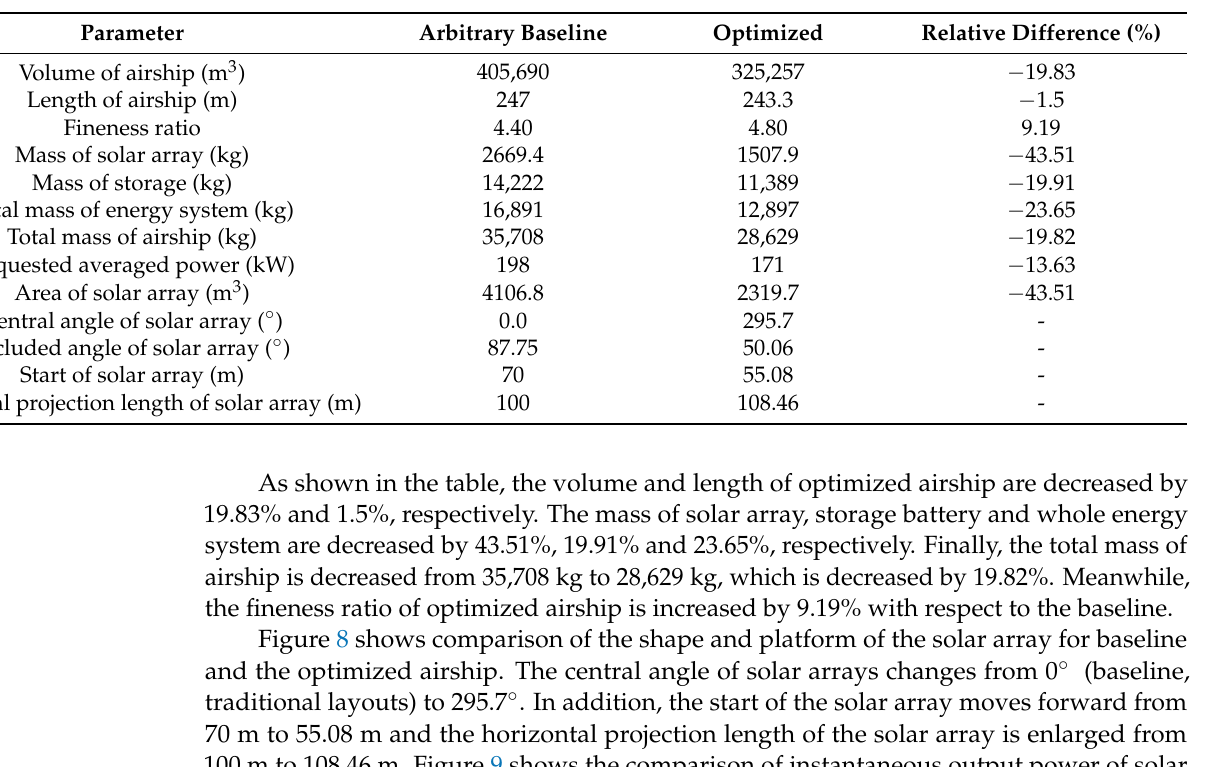
Table 3. Comparisons of key configuration parameters of baseline and optimized airship.